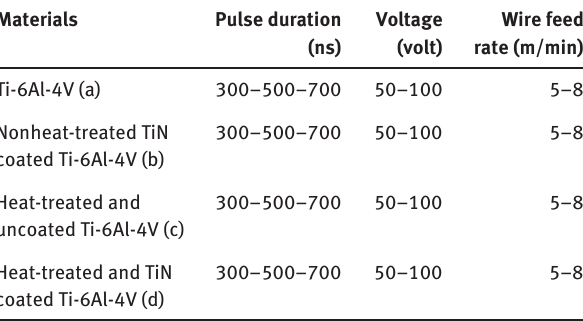
Table 2 WEDM experimental parameters.